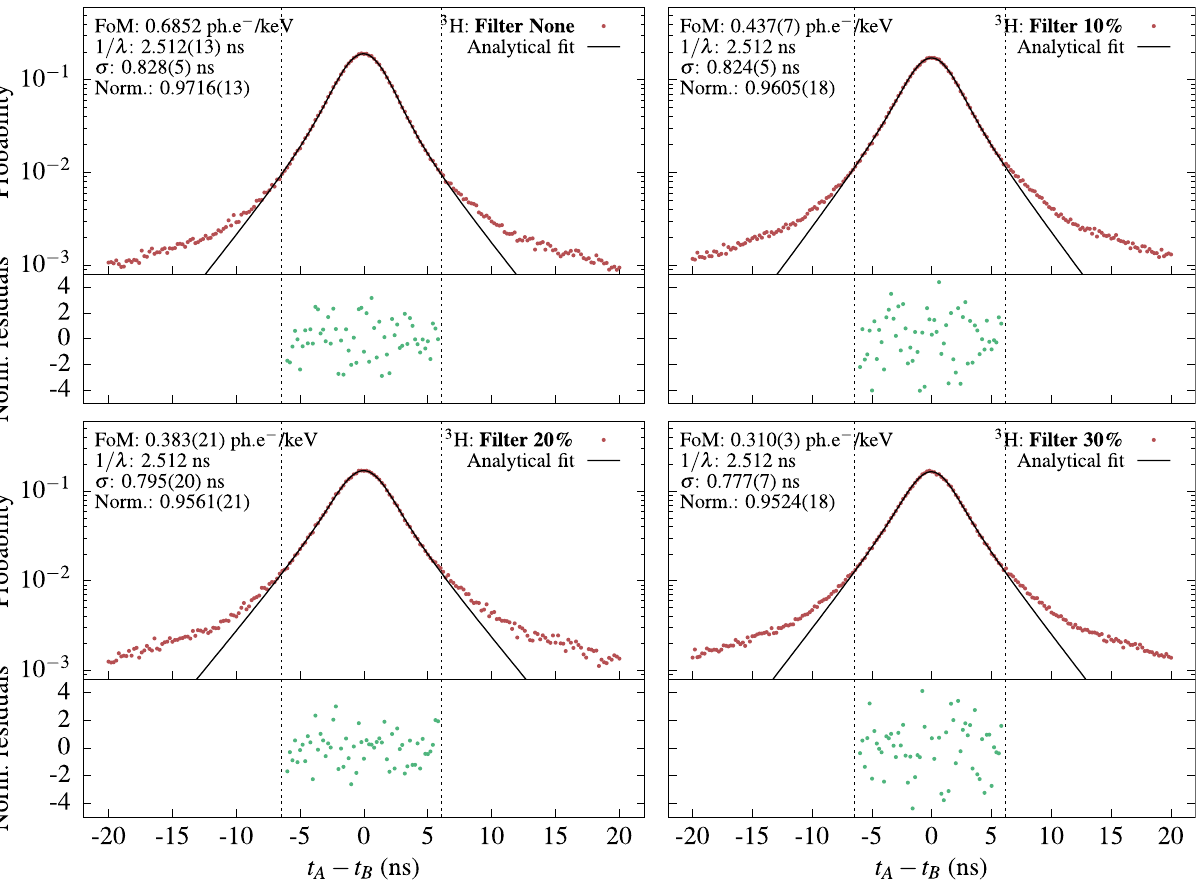
3 Figure 3. Cross-correlation spectra of a H sample with varying levels of grey filters. Top left: without filter, top right: filter with 10% opacity, bottom left: filter with 20% opacity, bottom right: filter with 30% opacity. The spectra are fitted with Eq. (29). The normalized residuals are in units of standard deviations. The values in brackets are the uncertainties as reported by the fitting algorithm. The parameters, for which the values are given without uncertainties were fixed during the fitting.